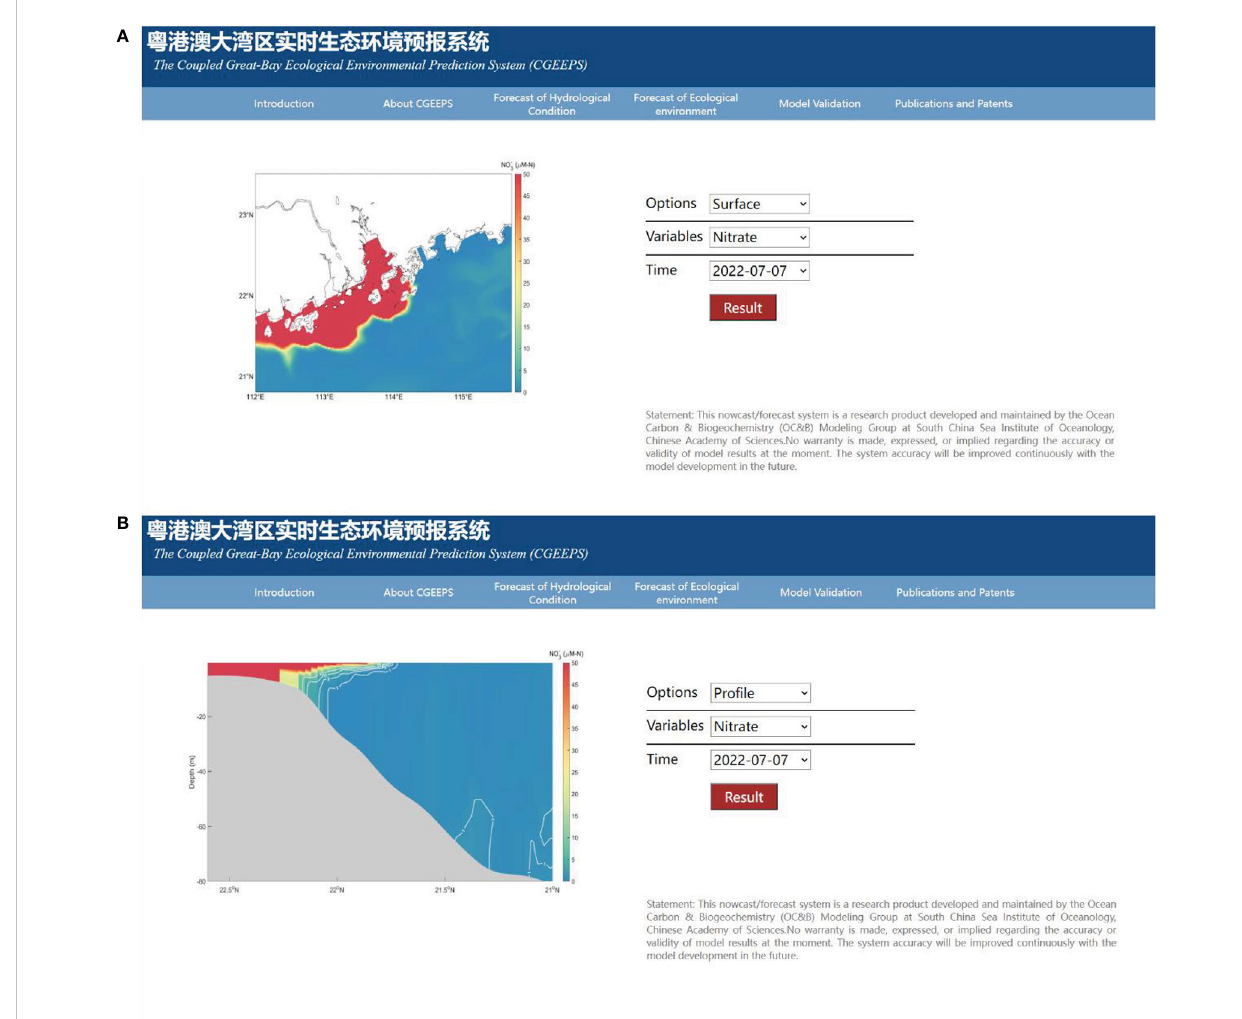
FIGURE 15 Real-time graphics displaying the surface (A) and vertical transect (B) of nitrate (Screen shot from July 07,